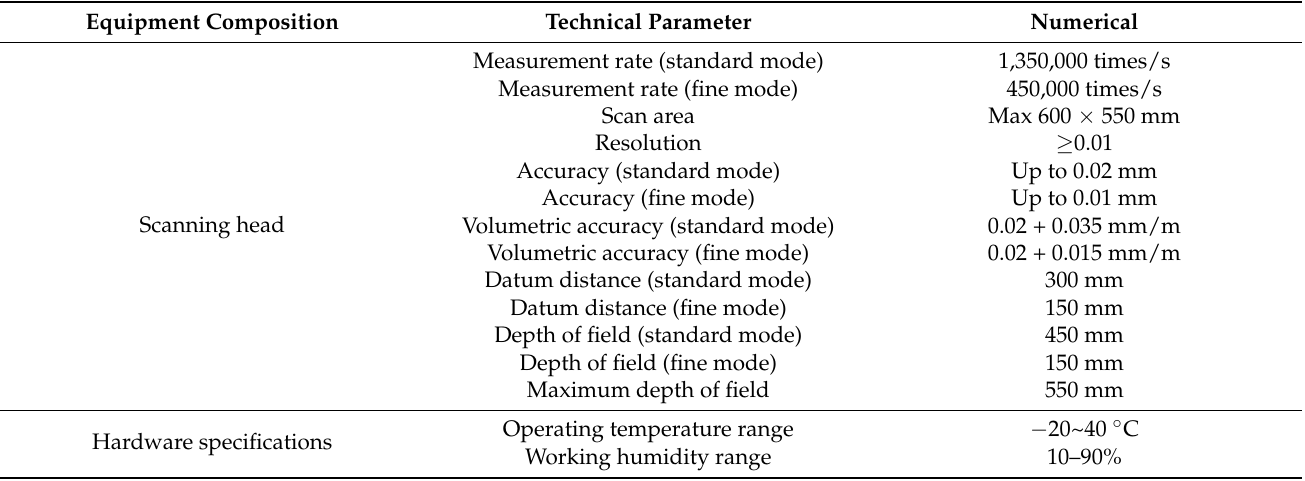
Table 6. Technical parameters of ZGScan717 PLUS.